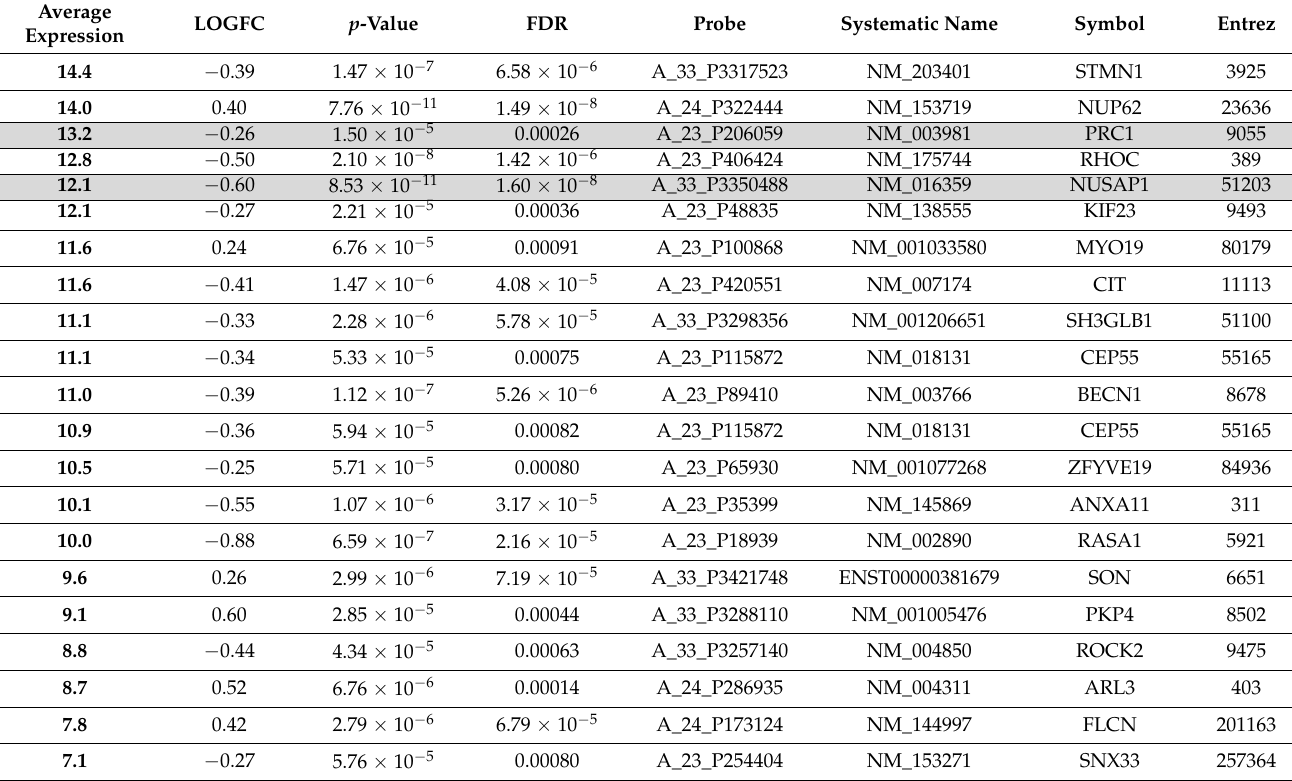
Table 2. Treatment with 1 µ M AZD2858 leads to the deregulation of genes associated with mitosis in the patient-derived cell line GBM1 as determined in an expression microarray (top hits are shown in the table). The highlighted genes in grey are genes with known functions in